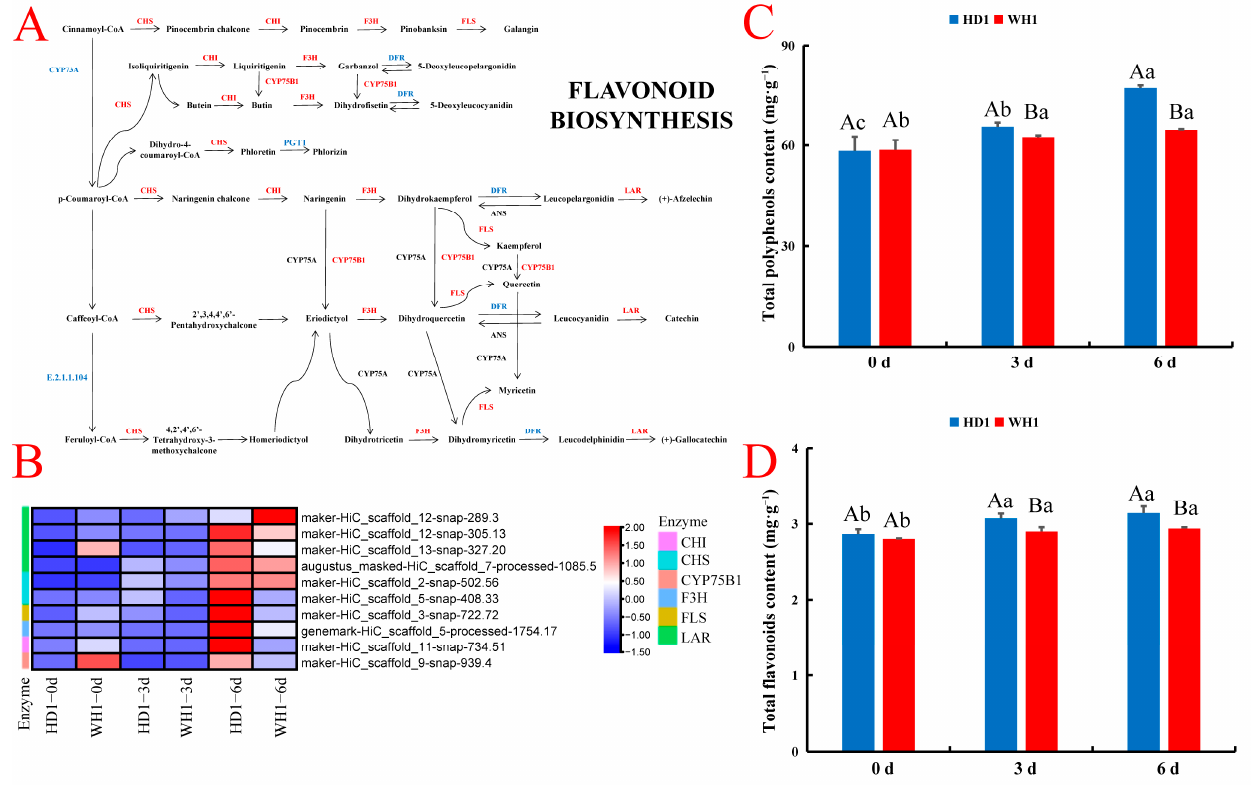
Figure 7. Expression analysis of DEGs enriched in the flavonoid biosynthesis pathway. ( A ): DEGs enriched in the flavonoid biosynthesis pathway in C. vietnamensis leaves. ( B ): Heatmap of flavonoid biosynthesis-related gene expression. CHI, chalcone isomerase; CHS, chalcone synthase; CYP75B1, flavonoid 3 (cid:48) -monooxygenase; F3H, flavanone 3-hydroxylase; FLS, flavonol synthase; LAR, leucoan- thocyanidin reductase. Values are the average FPKM value of each sample in each group. Genes in red or blue refer to up- or downregulation responding to drought, respectively. ( C ). Total polyphenol content of drought-tolerant cultivar HD1 and drought-sensitive cultivar WH1. ( D ). Total flavonoid content of the drought-tolerant cultivar HD1 and drought-sensitive cultivar WH1. All data are shown as the mean standard error. Different capital letters represent significant differences between cultivars; different lowercase letters indicate significant differences between treatments (Duncan’s test; p <